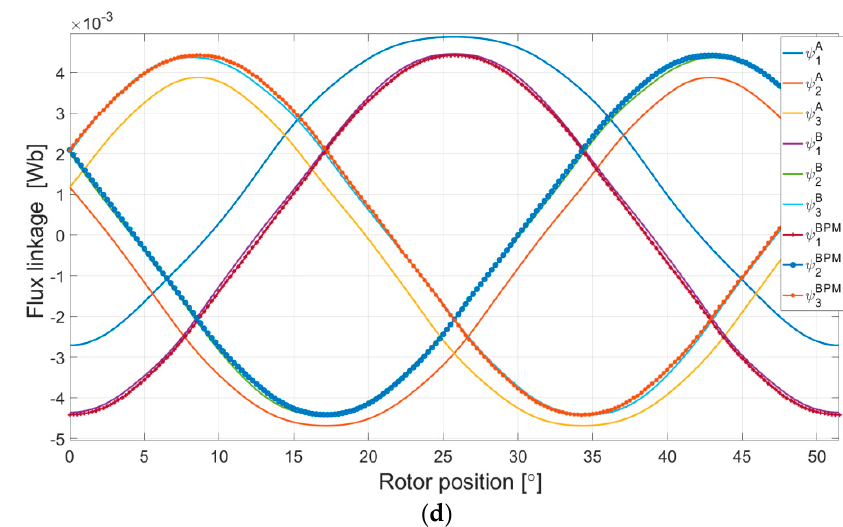
Figure 4. Static torque and flux linkage characteristics of the DCBLDCM. (a) Electromagnetic torque T e vs. rotor position θ in the DCO mode ( i A = i B = 0.5 I ref ) and SCO mode ( i A = I ref , i B = 0)—simulation. (b) Electromagnetic torque T e vs. rotor position θ in DCO mode ( i A = i B = 0.25 I ref ), channel A SCO mode ( i A = 0.5 I ref , i B = 0), and channel B SCO mode ( i A = 0, i B = 0.5 I ref )—laboratory test. (c) Flux linkage vs. rotor position θ in DCO mode ( i A = i B = 0.5 I ref )—simulation. (d) Flux linkage vs. rotor position θ in SCO mode ( i A = I ref , i B = 0)—simulation.